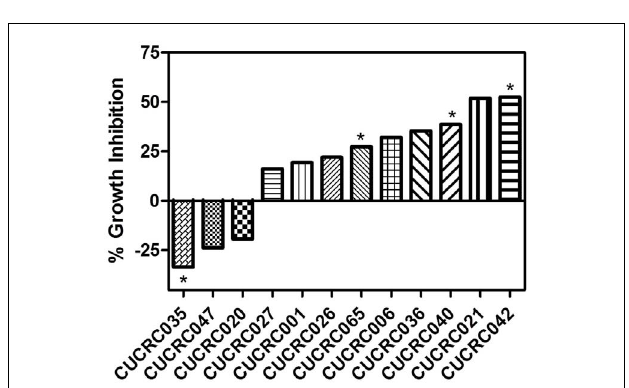
FIGURE 5 | Correlation of ABCB1 and ABCG2 expression and tumor growth inhibition in in vivo CRC cell line xenograft models. (A) Percent tumor growth inhibition of 11 CRC cell line xenograft models treated orally with 25mg/kg PF-309 twice daily. Percent growth inhibition was calculated from end of study tumor volumes in control and treated animals. * p < 0.05 for end of study tumor volumes treated versus control. (B) A heatmap for ABCB1 and ABCG2 expression in the tumor xenografts was generated from data acquired from baseline tumor samples (red